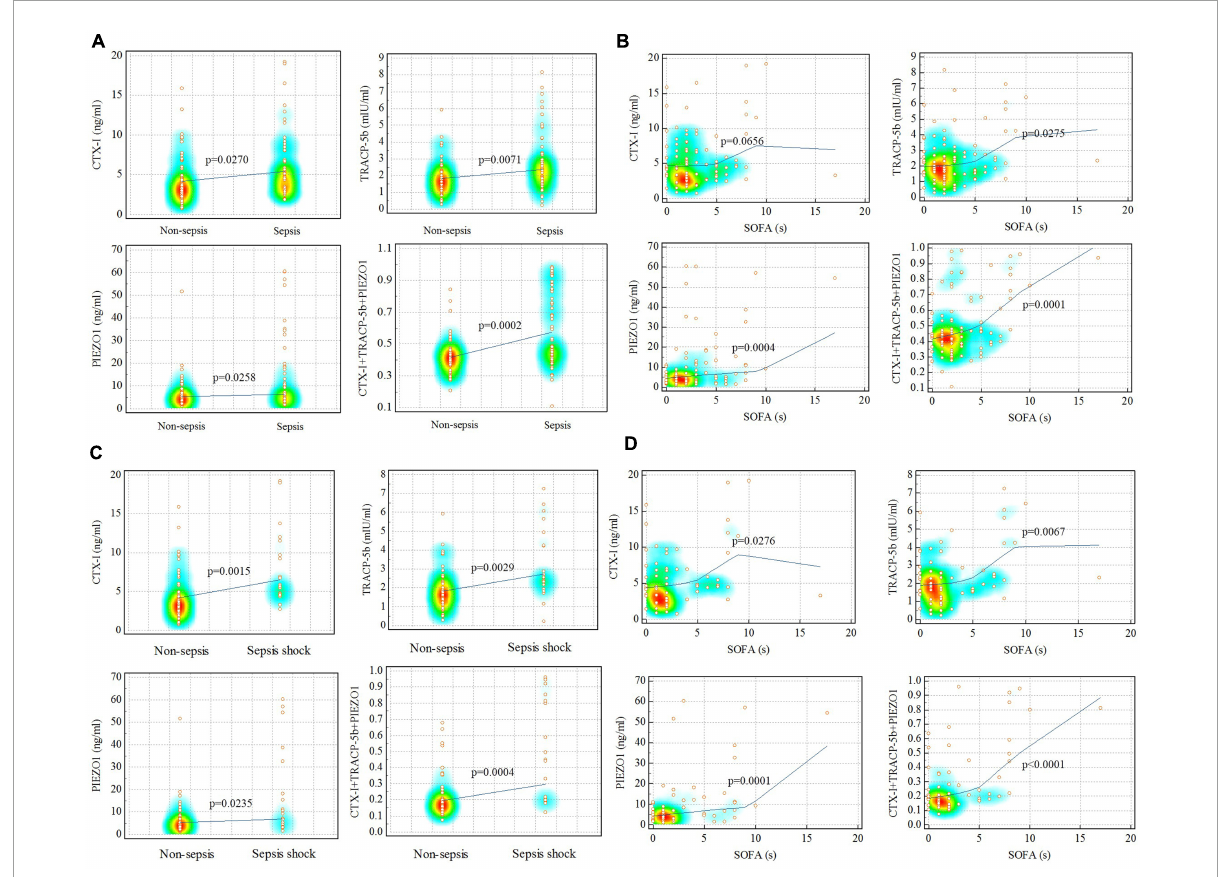
FIGURE2 Correlation analysis for sepsis and non-sepsis. (A,B) Sepsis vs. non-sepsis; (C,D) sepsis shock vs. non-sepsis. Red represented the data concentration